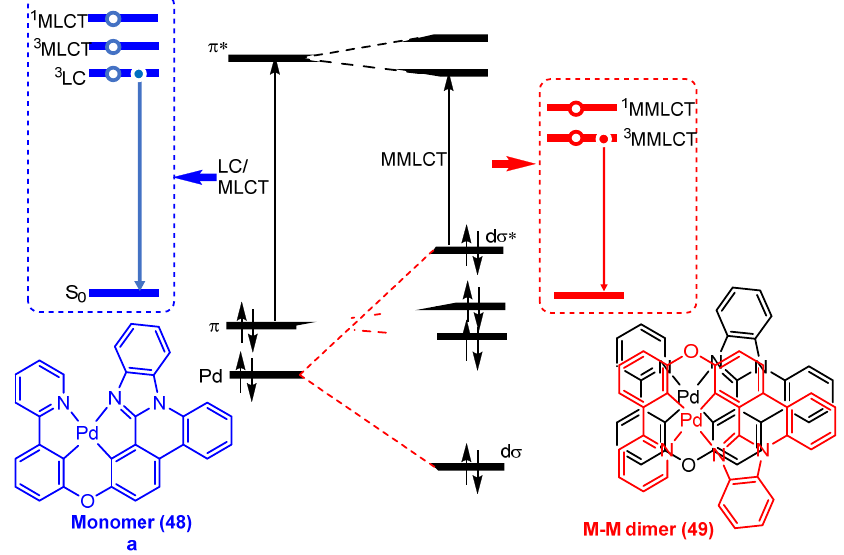
Figure 17. Schematic energy level diagrams for phosphorescent emitter 48 , featuring monomer 48 and M–M dimer 49 emissions. Adapted from [81].